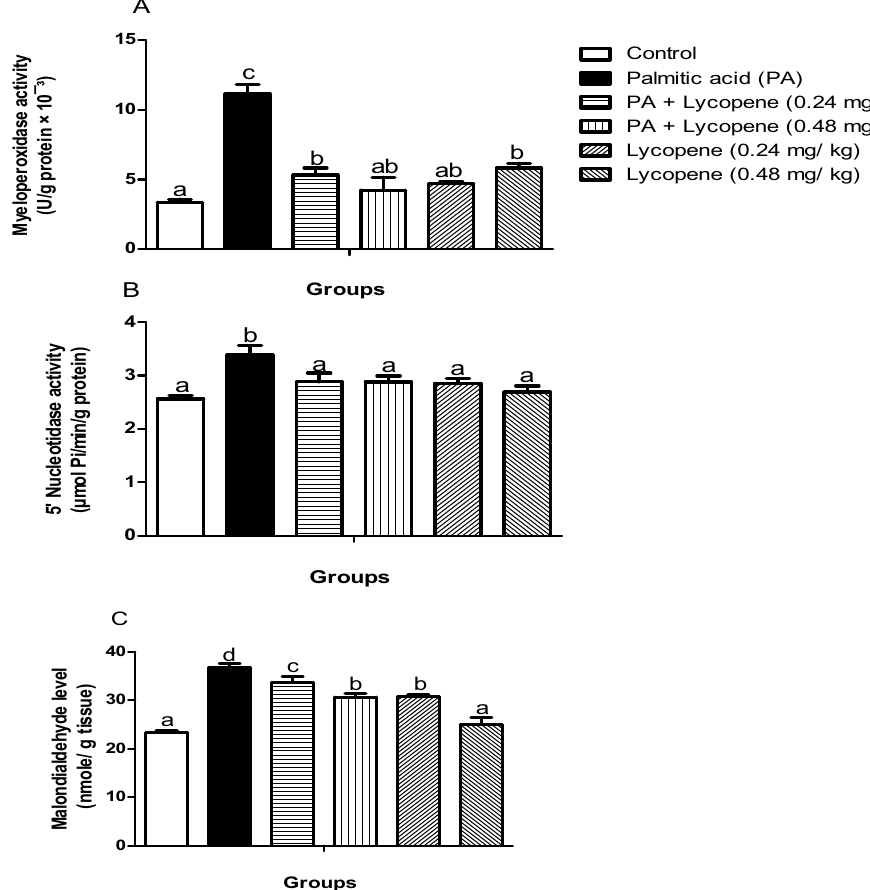
Figure 2. Effects of lycopene on oxidative stress markers of palmitic acid-induced neuro-inflammation in female rats. Values are expressed as mean ± S.E.M (n = 5). Bars with different letters are statistically distinct (p < 0.05). ( A ) Myeloperoxidase activity ( B ) 5 ′ Nucleotidases activity ( C ) MDA level. Data were analysed